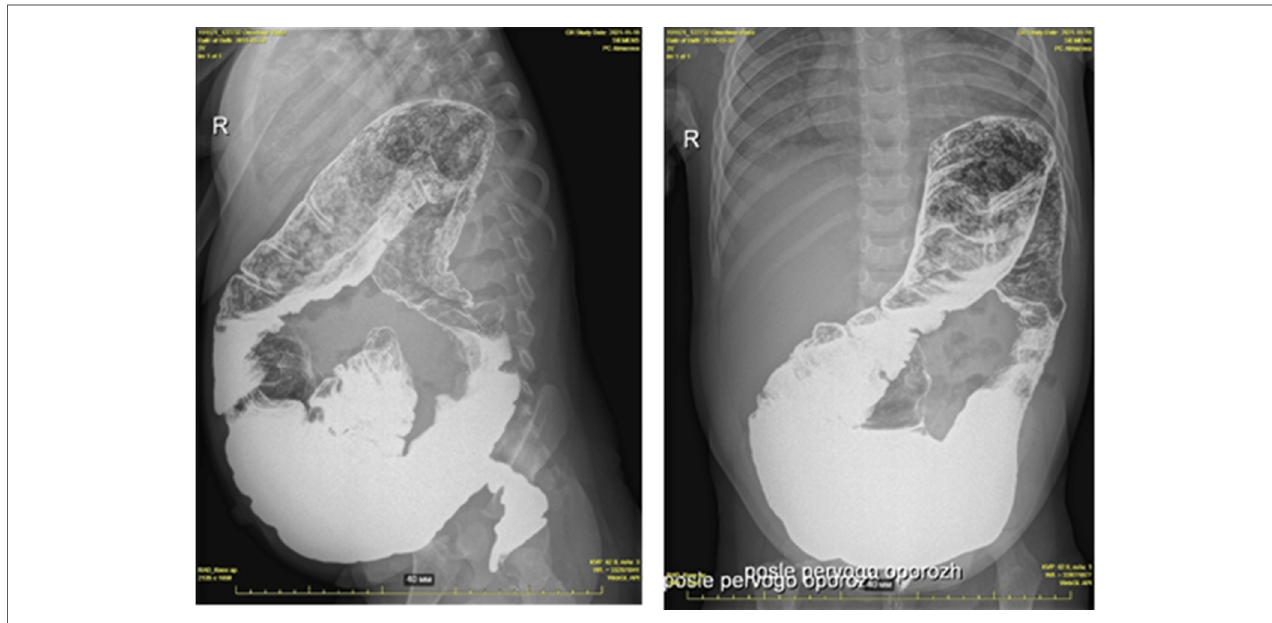
FIGURE 3 Hirschsprung ’ s disease. Barium enema showing reduced caliber of the rectum, followed by a transition zone to an enlarged-caliber